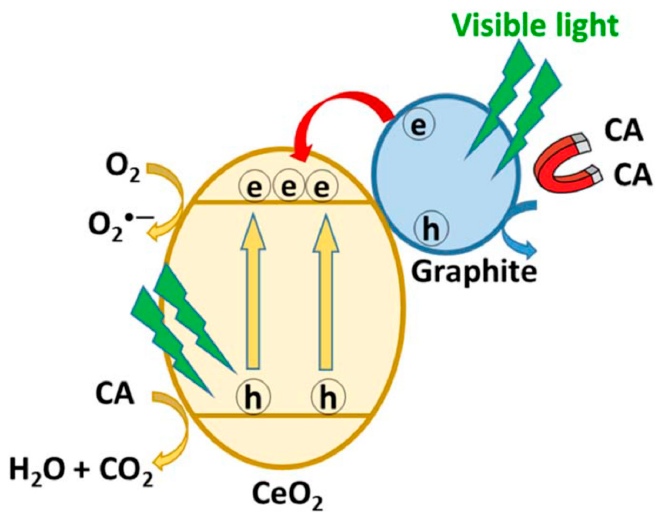
Figure 7. Photocatalytic degradation mechanism of cortisone acetate by using carbon-doped CeO 2 under visible light irradiation. Reprinted/adapted with permission from Ref. [121]. Copyright 2019 Institute of Physics.